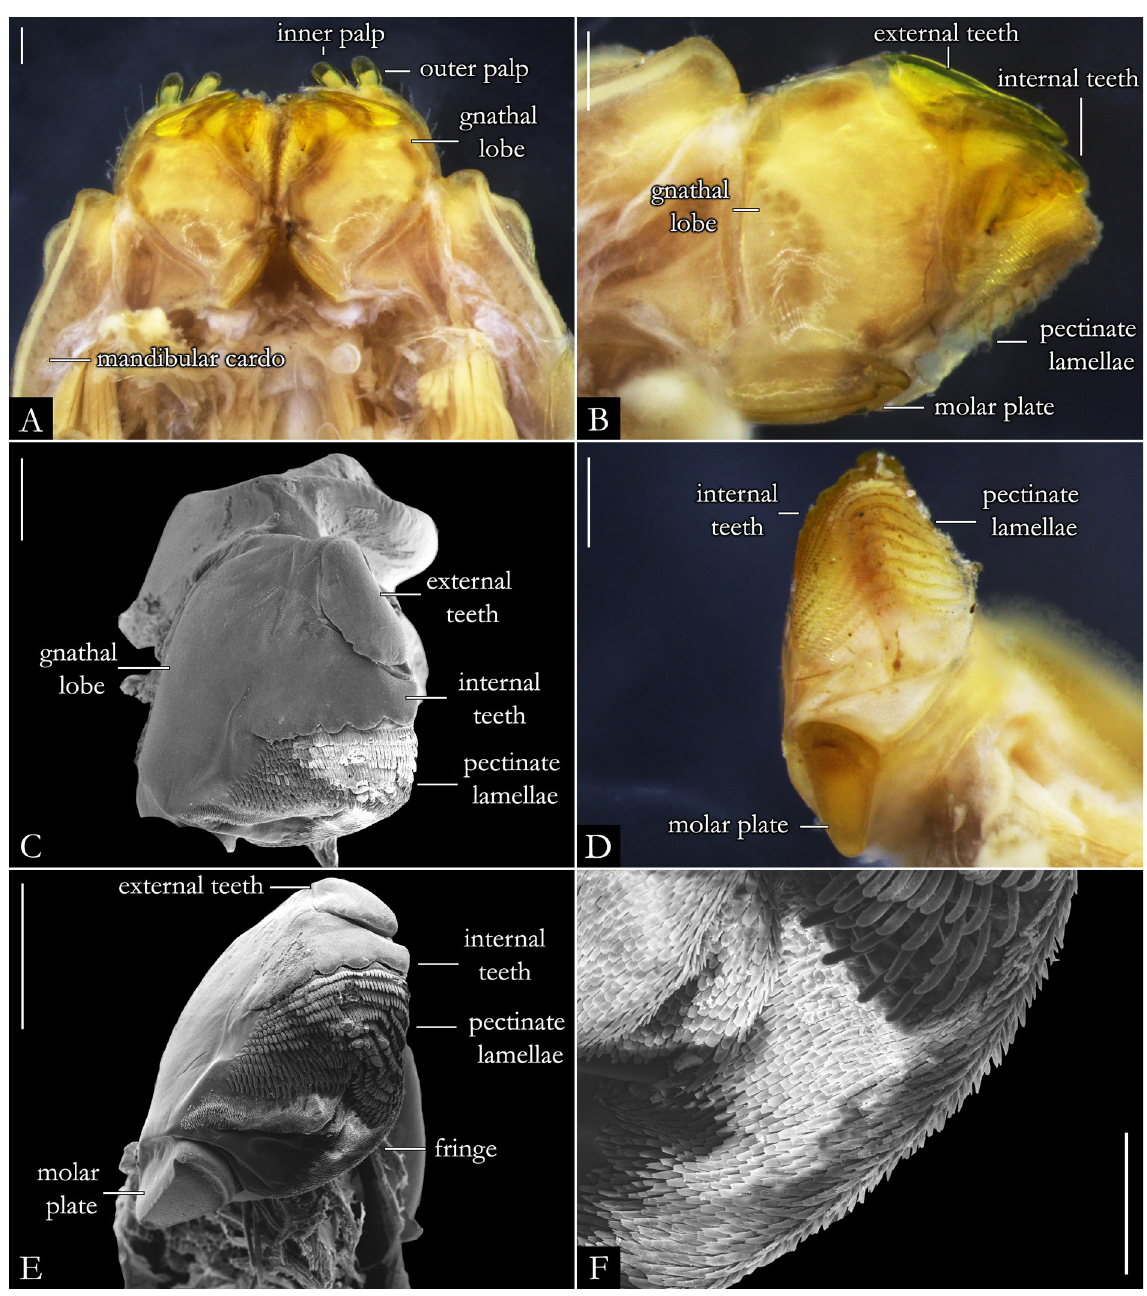
Fig. 20. SEM and stereoscopic images of mandibles. A . Ventral view, Pseudonannolene robsoni Iniesta & Ferreira, 2014 (IBSP 3526). B . Right mandible, P. robsoni (IBSP 3526). C . Oral view of right mandible, P. robsoni (IBSP 3505). D . Mesal view of right mandible, P. robsoni (IBSP 3526). E . Mesal view of right mandible, P. robsoni (IBSP 3505). F . Detail of pectinate lamellae of right mandible, P. robsoni (IBSP 3505). Scale bars: A, C, F = 200 µm; B = 300 µm; D = 500 µm; E = 250